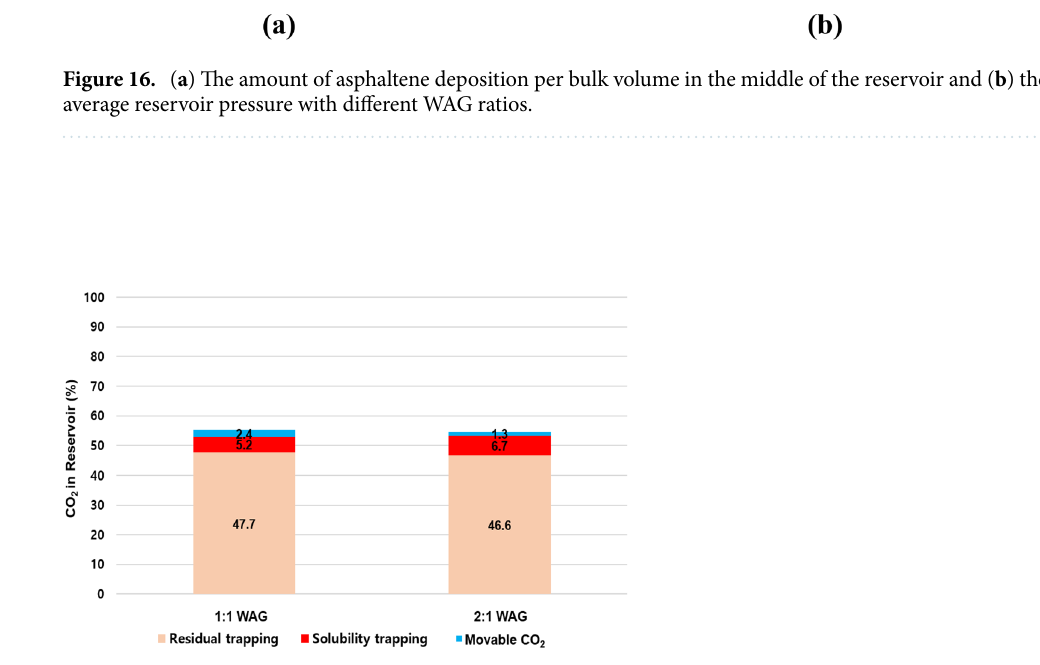
Figure 17. Remaining CO 2 in the reservoir according to trapping mechanism with various WAG